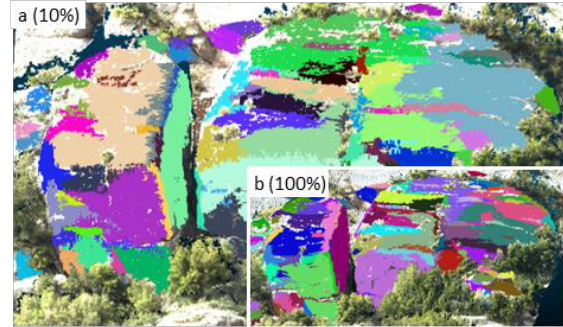
Figure 8. Result of plane segmentation for a point cloud with